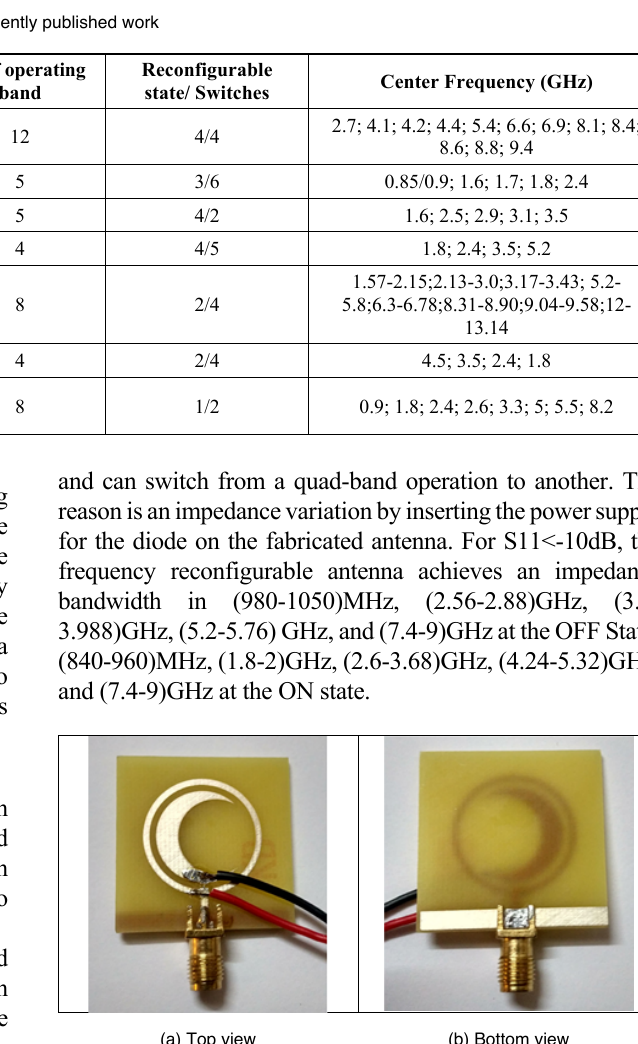
FIGURE 6. Fabricated reconfigurable